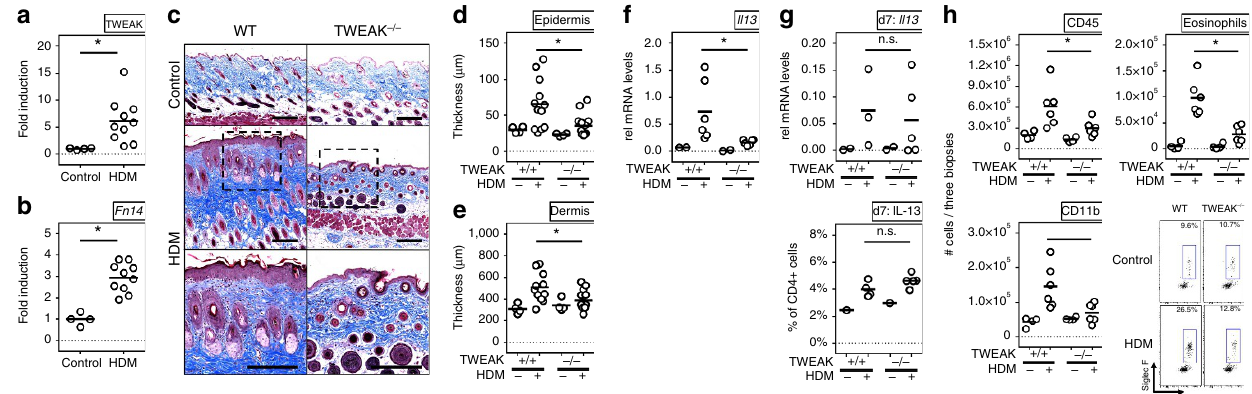
Figure 1 | TWEAK controls disease activity in HDM-induced AD. WTand TWEAK-deficient mice were treated epicutaneously with HDM on the shaved back for 23 days to induce AD-like disease. ( a , b ) TWEAK and Fn14 mRNA fold induction in WT mice relative to expression in skin from naive animals (Control). Combined results from three experiments. Each data point represents one individual mouse. ( c ) Representative Masson’s trichrome staining of skin sections from WT and TWEAK (cid:2) / (cid:2) animals treated with HDM or PBS control. Bar represents 200 m m. ( d , e ) Epidermal and dermal thickness measured on trichrome-stained sections. Results combined from three independent experiments. Each data point represents one animal. ( f ) IL-13 mRNA in skin lesions on day 23. Combined from two experiments. ( g ) IL-13 mRNA in skin biopsies (top), and frequency of IL-13 positive CD4 þ T cells in skin-draining lymph nodes on day 7 (bottom). Four mice per group. ( h ) Total numbers of CD45 þ cells (left top), CD45 þ CD11b þ monocytes (left bottom), and SigF þ CD45 þ CD11b þ Ly6G (cid:2) eosinophils (right top and bottom) in skin biopsies on day 23. Combined results from two experiments, with each data point one animal. Bars represent mean values. The Mann–Whitney U -test was performed to compare the groups. Asterisks indicate P o 0.05. n.s. indicates nonsignificant